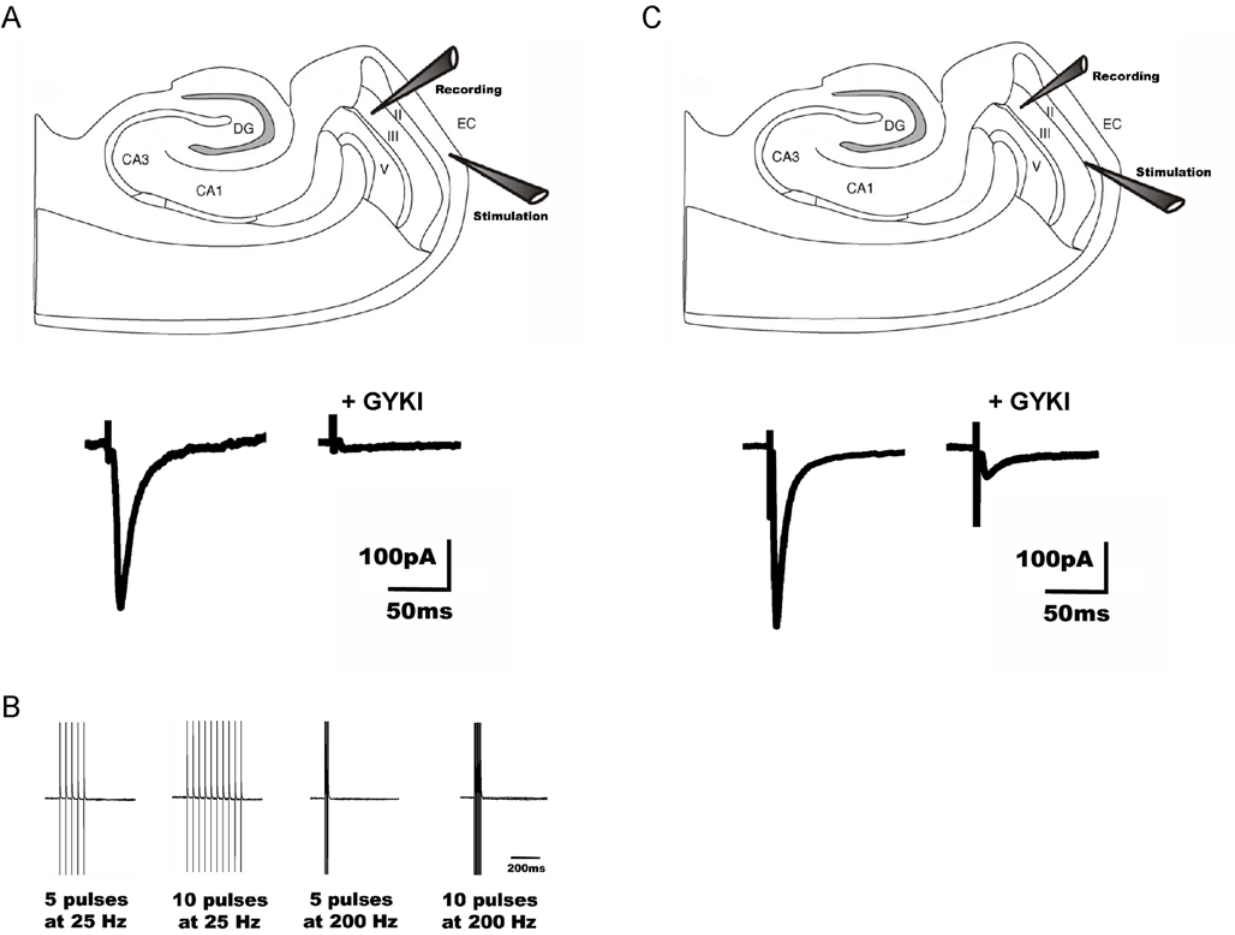
Figure 5. Pathway specific activation of synaptic KARs in LIII mEC pyramidal neurons. (A, B) Recorded LIII mEC pyramidal neurons were held in the whole-cell mode while stimulating the afferent pathway LI mEC. (A, lower panel) In the presence of GYKI (20 m M), no synaptically evoked EPSC KA is detected (n=8) as seen in an example trace from a single experiment. (B) High frequency stimulations (5 pulses at 25 Hz, 10 pulses at 25 Hz, 5 pulses at 200 Hz and 10 pulses at 200 Hz) were performed in the presence of GYKI. There was no detectable EPSC KA under these stimulation conditions as well indicating the absence of synaptic KARs upon stimulation of this pathway. (C) To determine, whether any other input pathway would yield a significantly higher proportion of synaptic KAR mediated current, we stimulated at the border of LII–III mEC. In the presence of GYKI, an EPSC KA was observed (10.24% 6 1.1% of baseline; n=5) as seen in an example trace from a single experiment (C, lower panel) . Thus by stimulating a different pathway, a EPSC KA could be evoked on LIII mEC pyramidal neurons, suggesting the existence of synaptic KARs in a pathway specific manner.